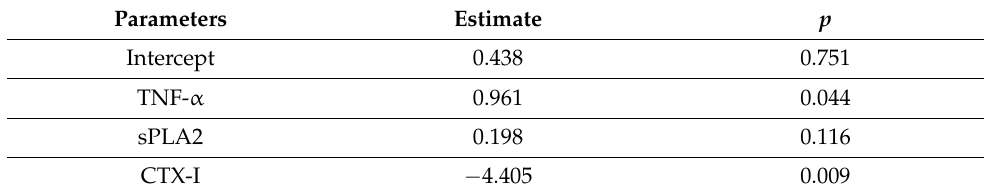
Table 7. Estimates of the multiple logistics regression model and their significance level.